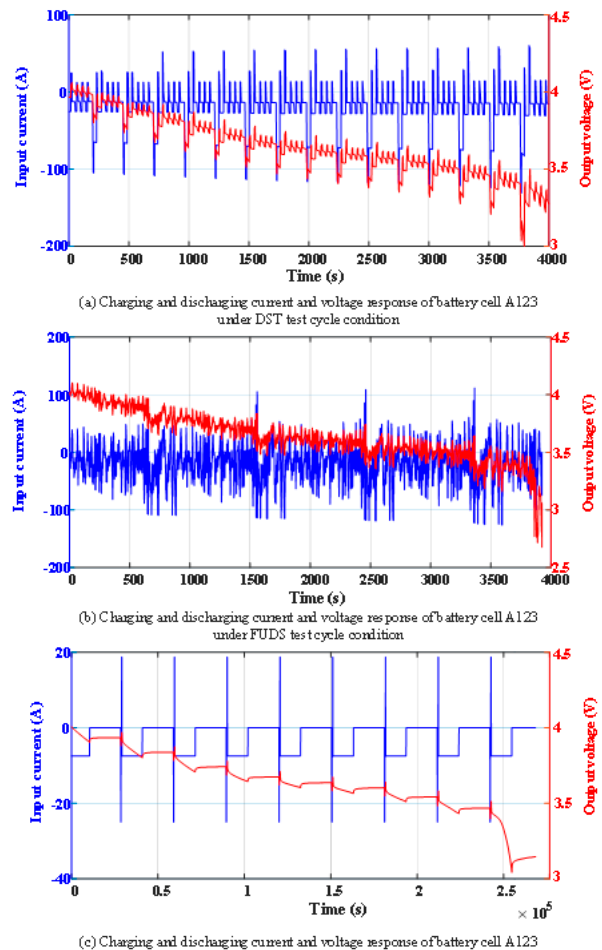
Figure 8. Charging and discharging current and voltage response of battery cell A123 under different test cycle conditions.